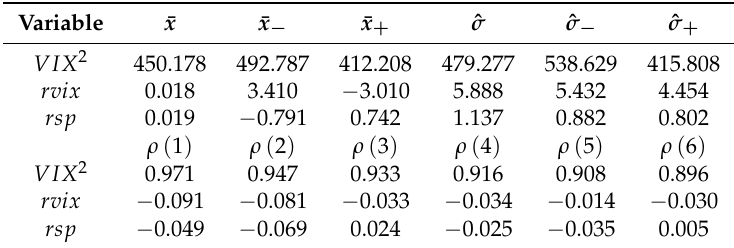
Table 1. Summary Statistics